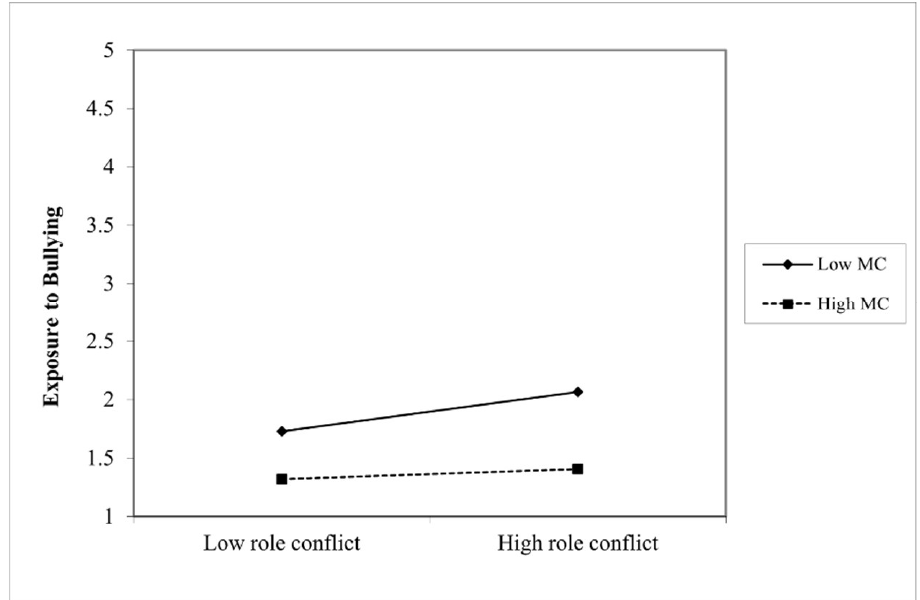
Figure 5. The moderating effects of managerial competencies on the indirect effect of role conflict and exposure to bullying. Note: MC stands for managerial competencies.